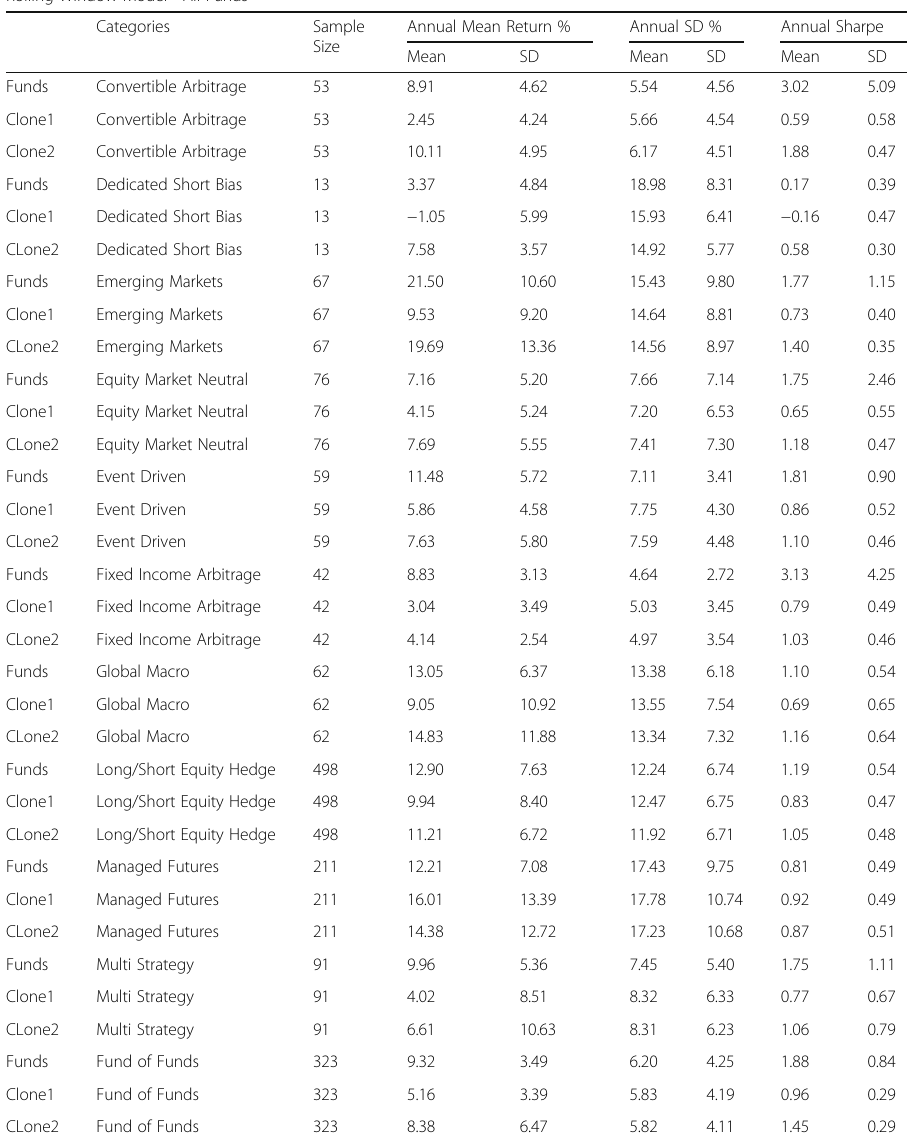
Table 2 Performance comparison for rolling window model for all funds and their clones Rolling Window Model - All